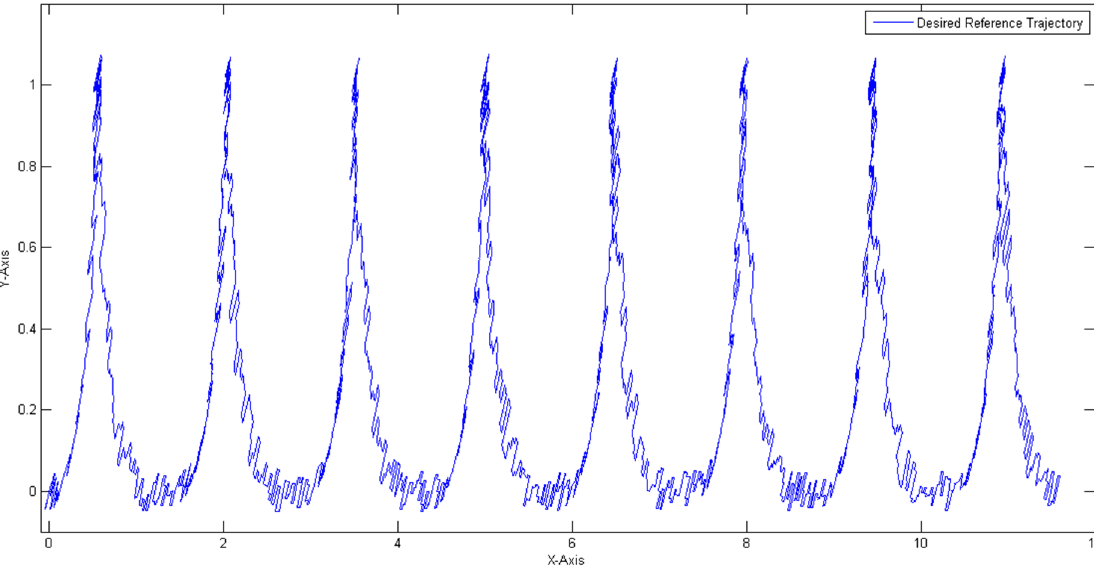
Figure 12. Reference trajectory with noise for the autonomous mobile robot. Table 4. Fuzzy rules for control.